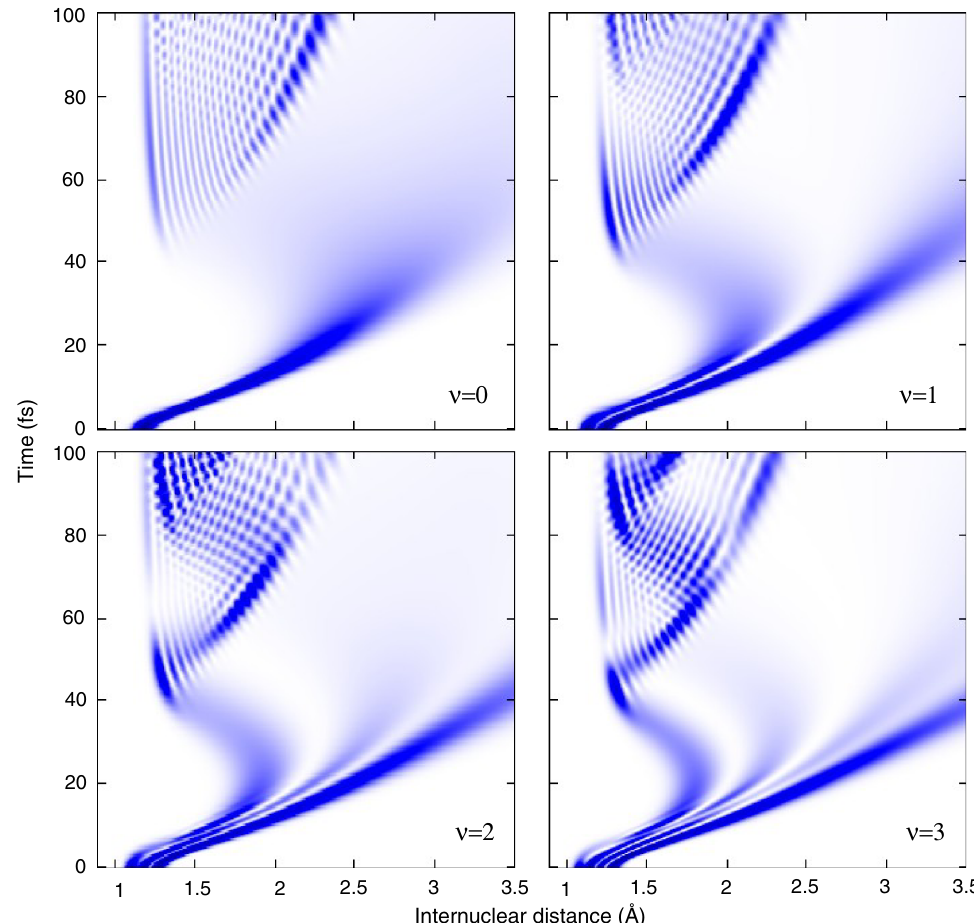
state jj (cid:3) ð (cid:5) Þij (2) following resonant g